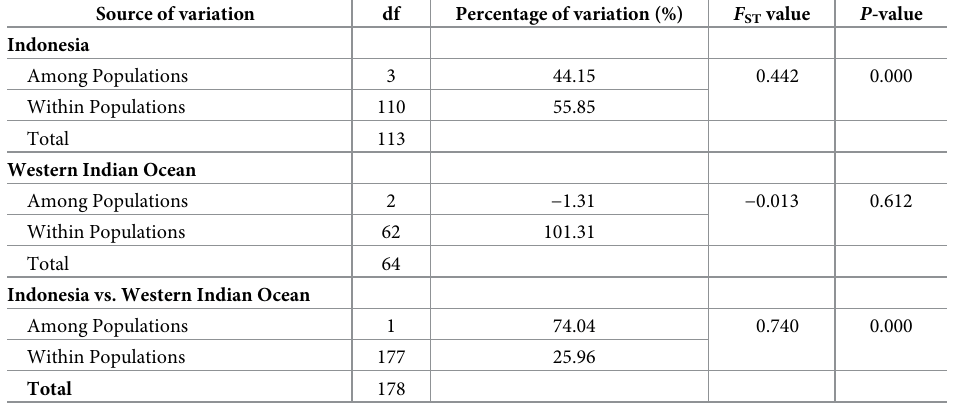
Table 5. Analysis of molecular variance (AMOVA) for the percentage of variation (%), F ST value, and significance level ( P -value) in S . lewini samples from Indonesian, the Western Indian Ocean, and between Indonesian and Western Indian Ocean populations. Source of